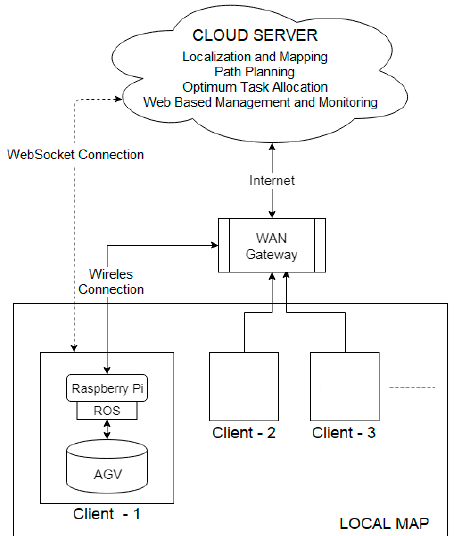
Figure 5. Developed cloud robotic architecture.